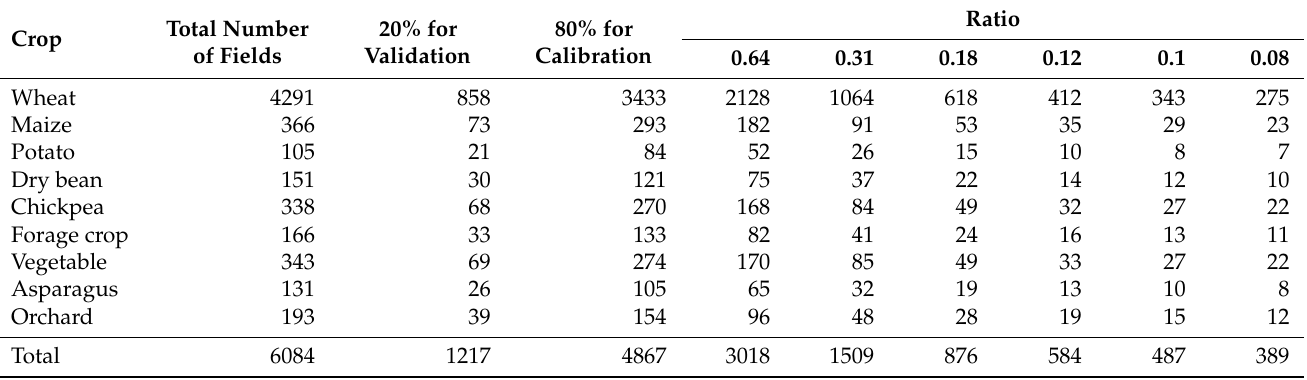
Table 2. Number of fields per crop type used for validation and calibration, as well as for the six ratios (Scenario